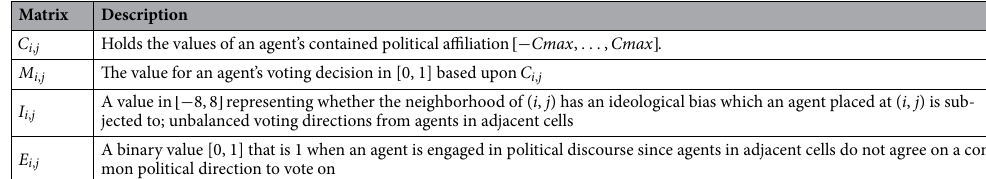
Table 1. The matrices proposed and a description of their use.